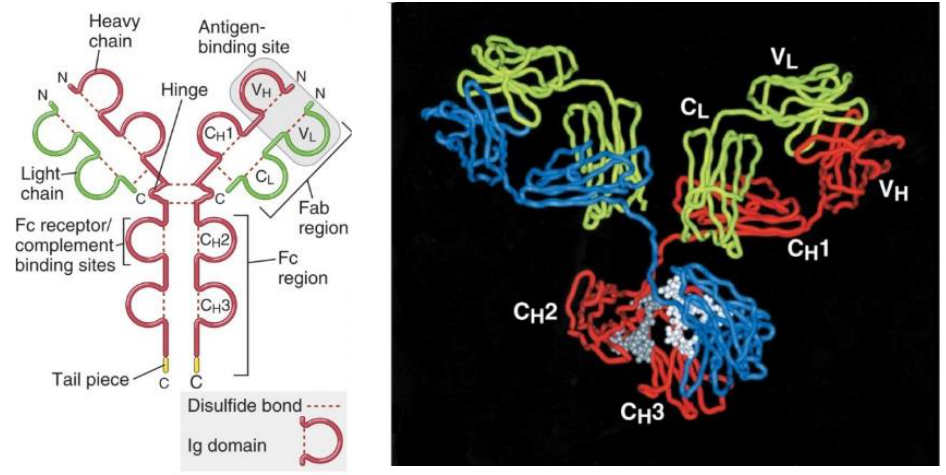
Figure 1. Schematic diagram of a secreted IgG molecule. The antigen-binding sites are formed by the juxtaposition of V L and V H domains. The heavy chain C regions end in tail pieces. The locations of complement- and Fc receptor–binding sites within the heavy chain regions. Reprinted with permission from Ref. [5]. Copyright 2017 Elsevier.